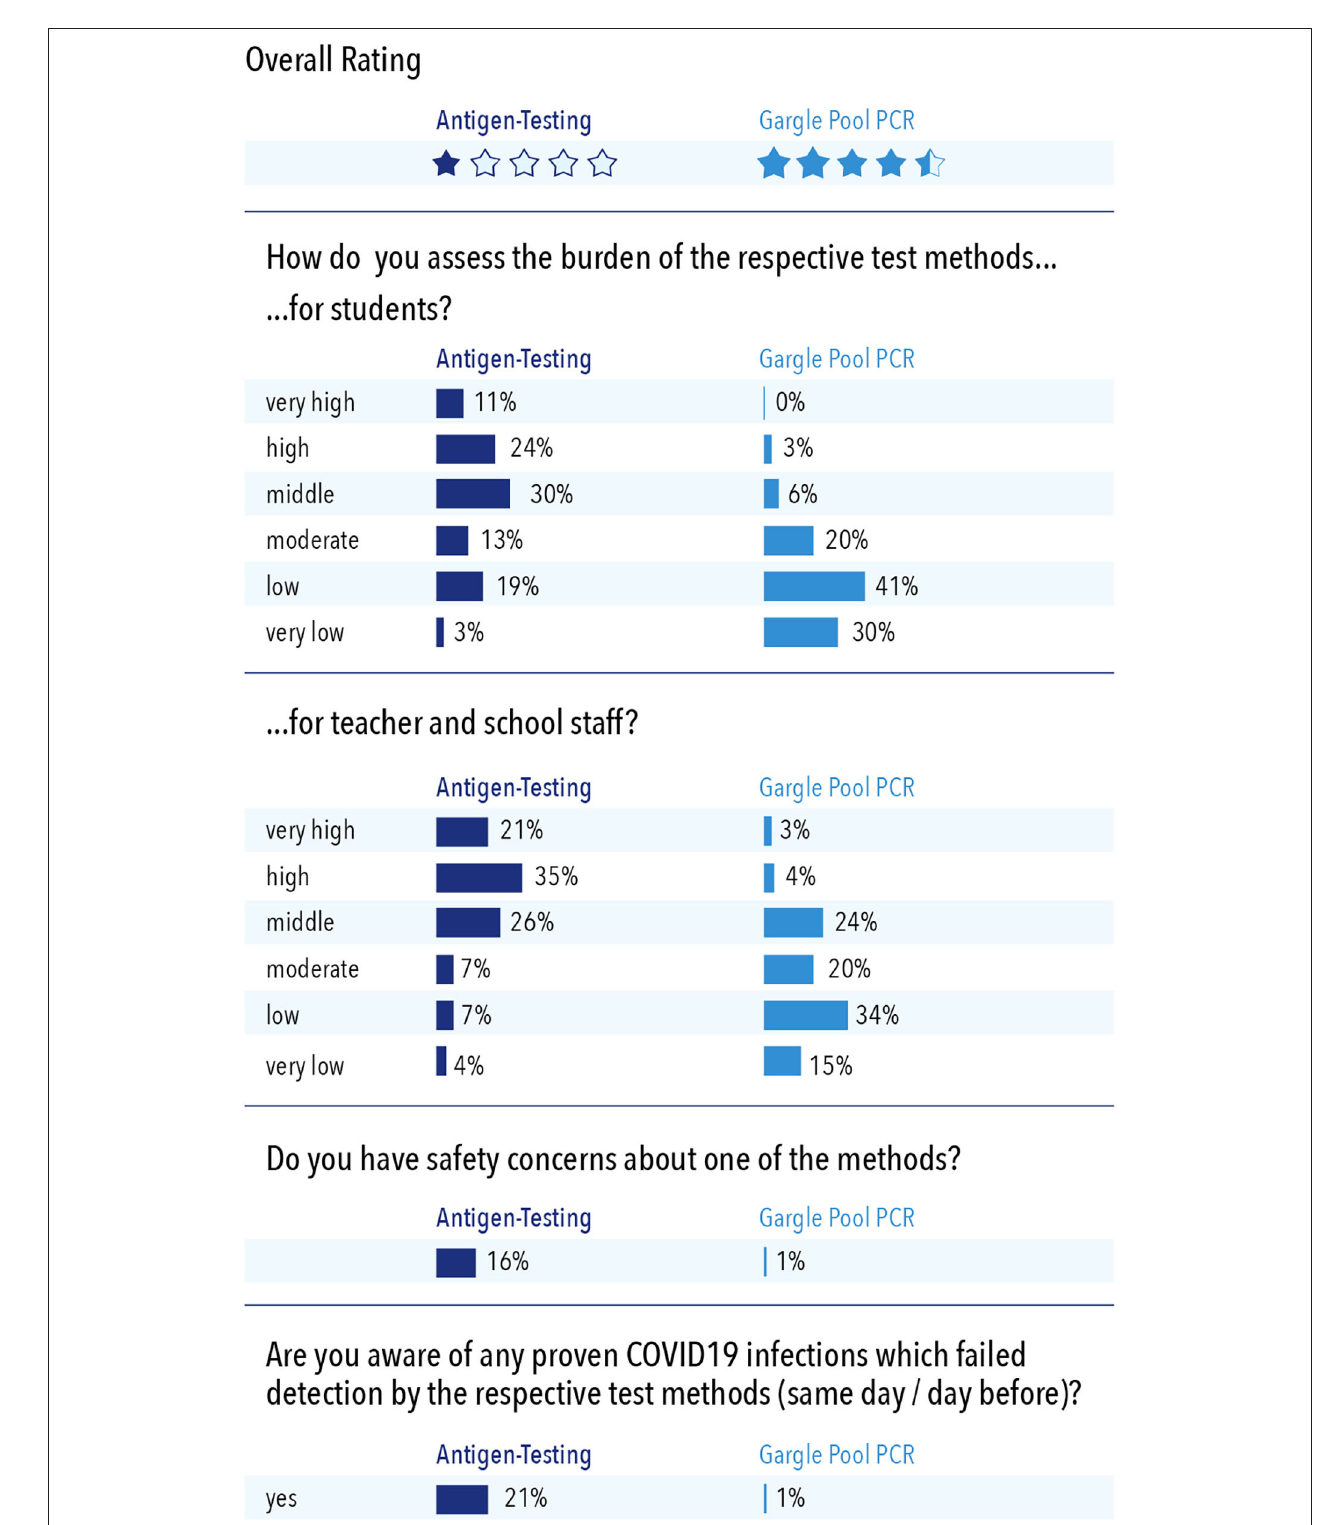
FIGURE 5 | Indicators of acceptance of antigen tests and gargle pool PCR tests in schools based on 71 responses from school heads (74% participation rate).